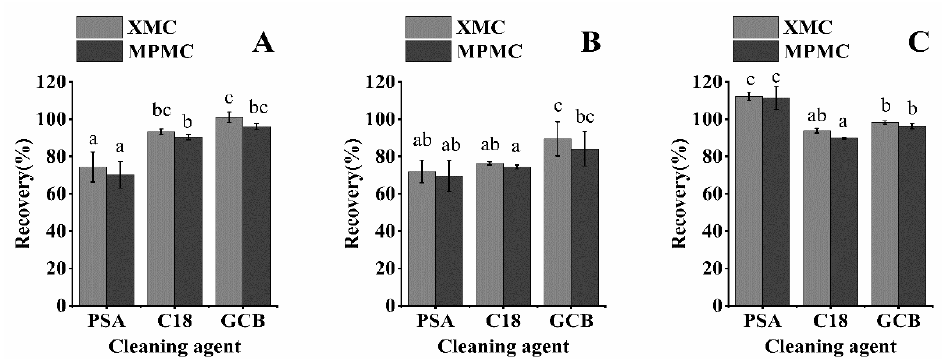
Figure 3. Effect of various cleaning agents on the purification of three matrix samples (spike at 0.1 mg/kg): ( A ) rice straw, ( B ) rice husk, and ( C ) brown rice. (abc: different letters represent statistically significant differences between the recovery rates of XMC and MPMC with different cleaning agents, p <